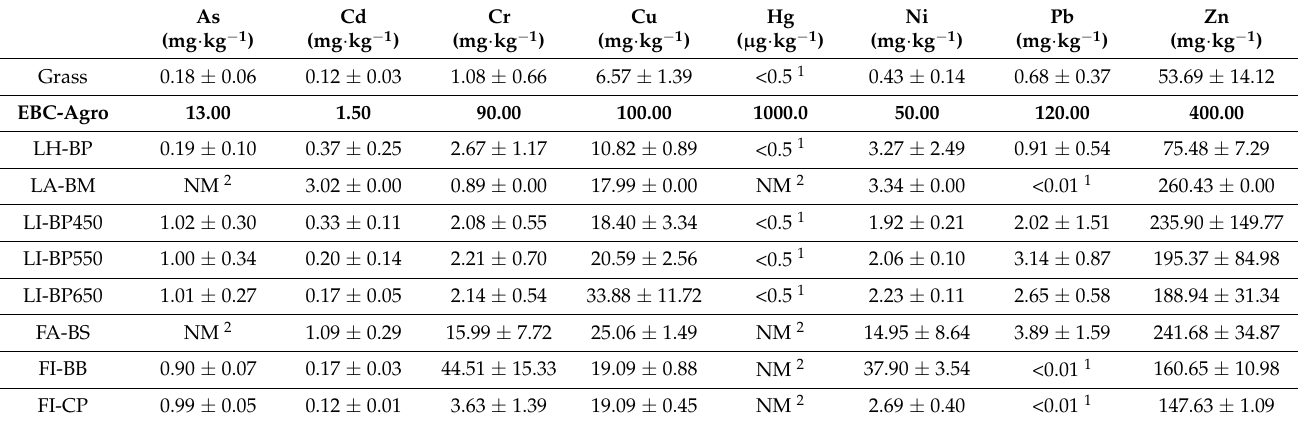
Table 4. Heavy-metal concentrations of the grass feedstock and produced biochars on a dry basis. For all parameters, the mean value and the standard deviation of the mean are presented ( n = 3). Additionally, the limit values for the contents in biochar proposed by the EBC for agricultural application are given. Detection limit 0.01 mg · kg − 1 for all elements, except Hg with a detection limit of 0.05 µ g · kg − 1 , of fresh matter (FM)